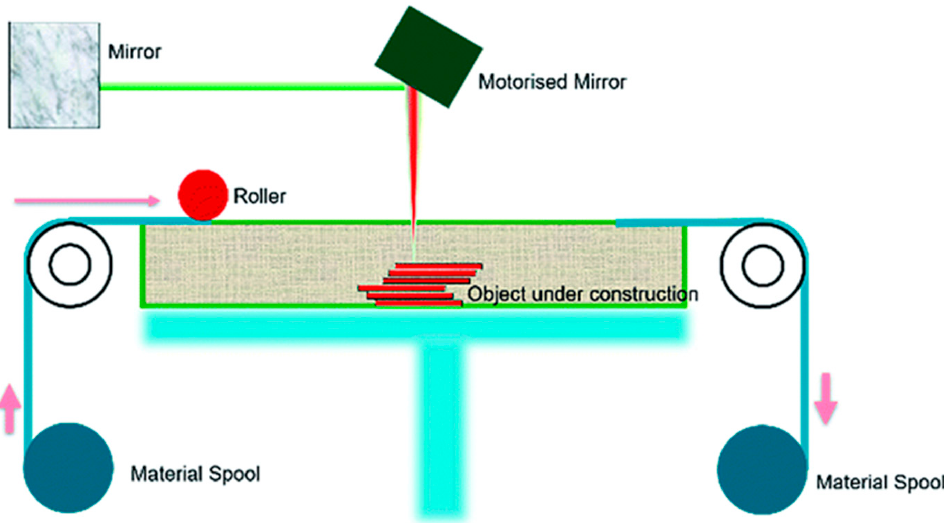
Figure 7. Schematic representation showing sheet lamination process. Reproduced from Ref. [46]. with permission from the Royal Society of Chemistry.